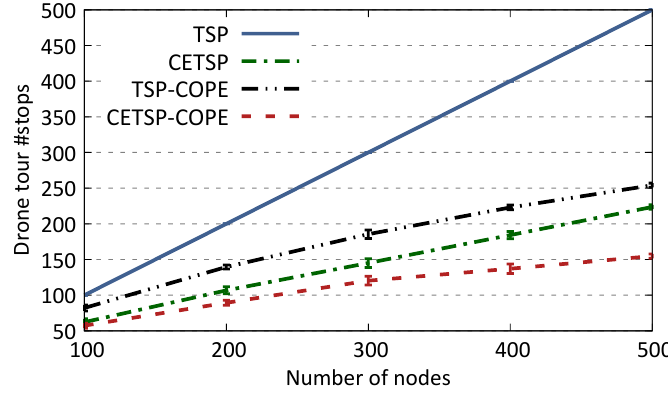
Figure 10. Number of